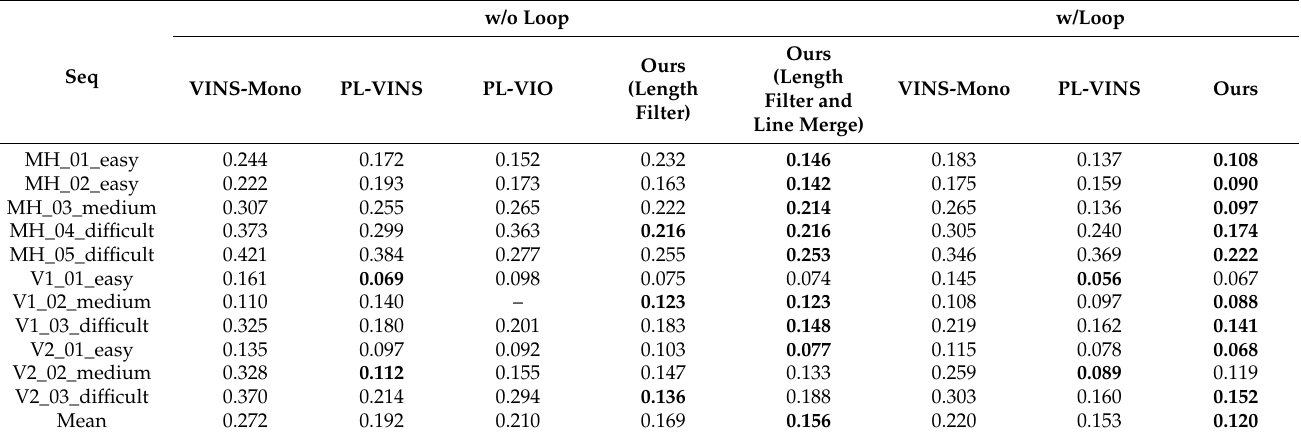
Table 2. RMSE ATE (M) comparison of VINS-Mono, PL-VINS, PL-VIO and ours